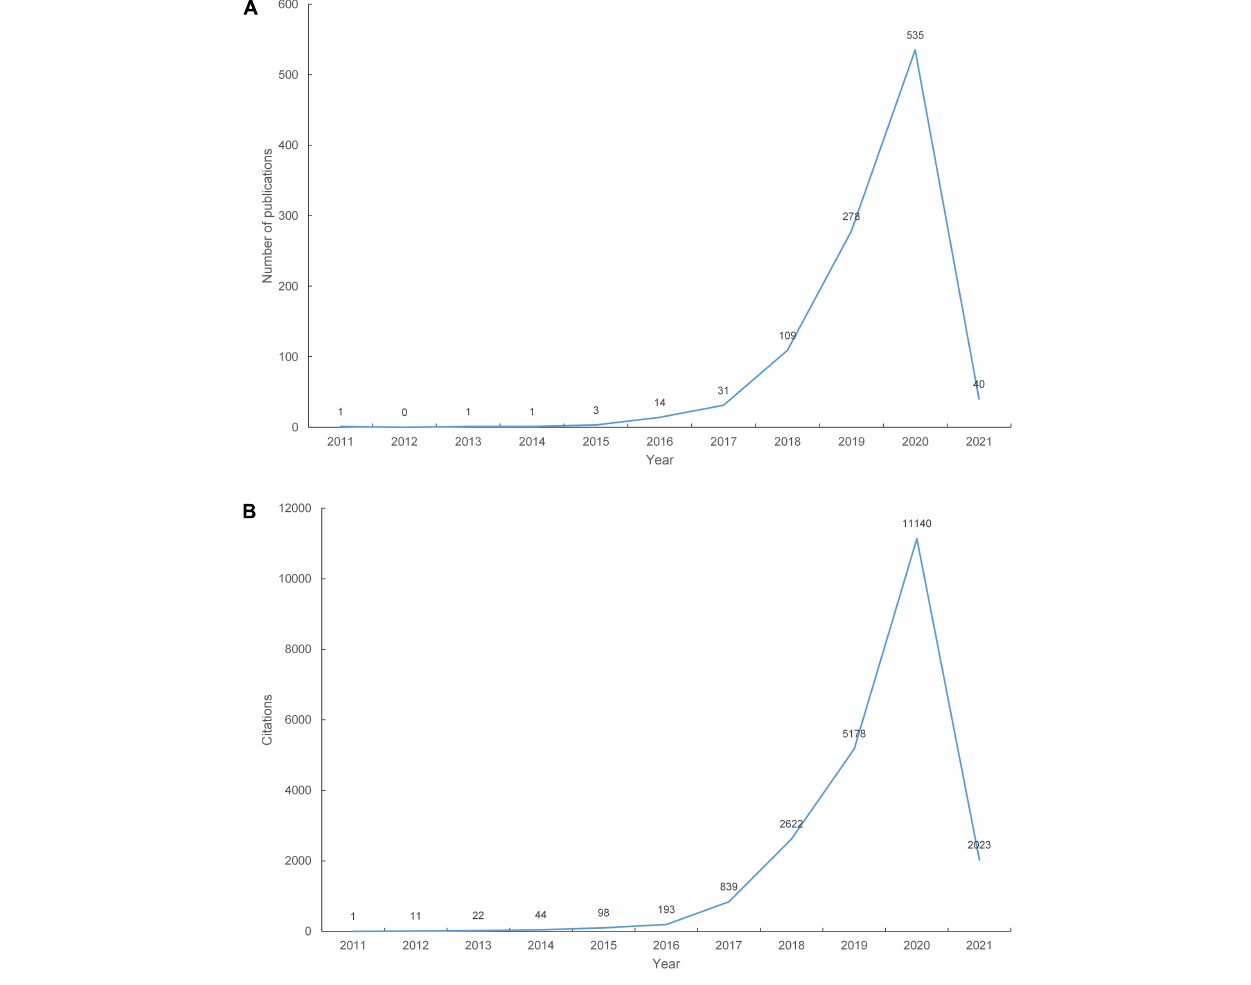
Frontiers in Cell and Developmental Biology |